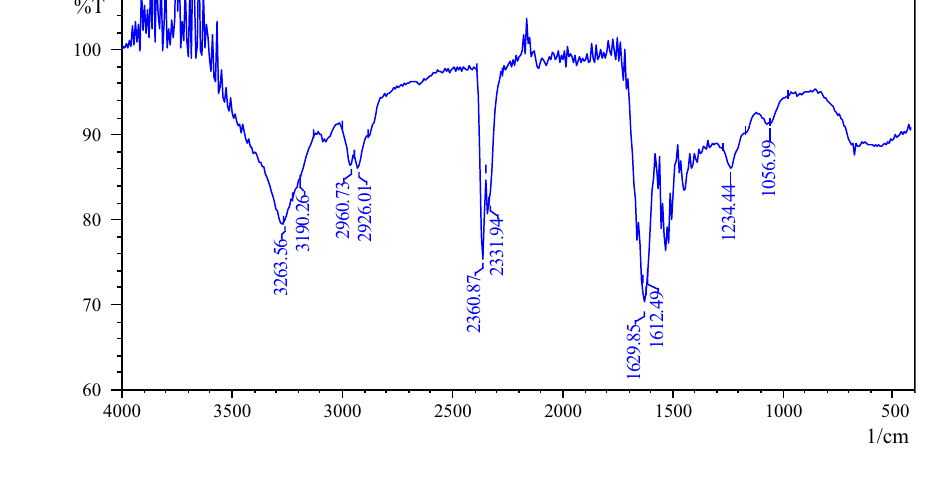
Fig. 4 A schematic diagram which shows possible interac- tion between Cr(VI) and active functional groups of chicken